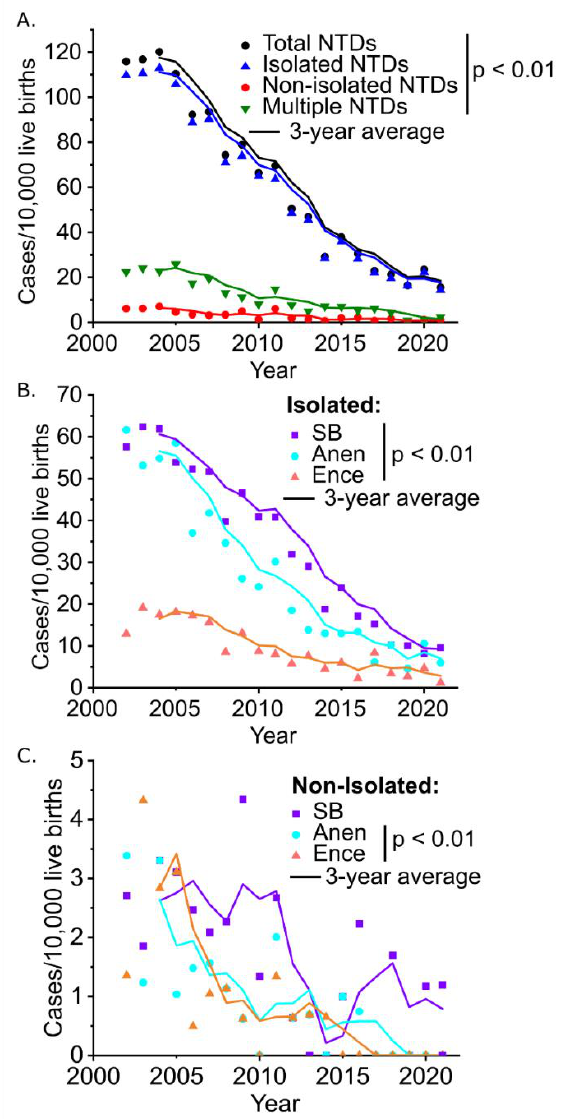
Figure 3. Time trends in the prevalence of NTDs in five counties in Shanxi province of Northern China, 2002 – 2021. ( A ). Total NTDs; ( B ). Isolated NTDs; ( C ). Non-isolated NTDs. In 2002, only the data of Zezhou, Pingding, and Taigu are presented; In 2003, the data of Zezhou, Pingding, Taigu, and Shouyang are presented; In 2004 – 2021, the data of Zezhou, Pingding, Taigu, Shouyang, and Xiyang are all